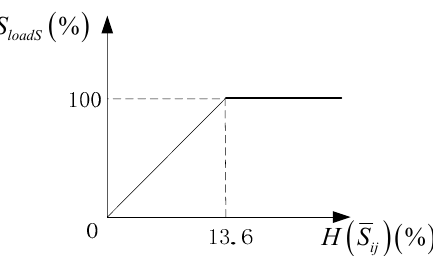
Figure 3. Mathematical relationship between the line flow off-limit and the load losses.